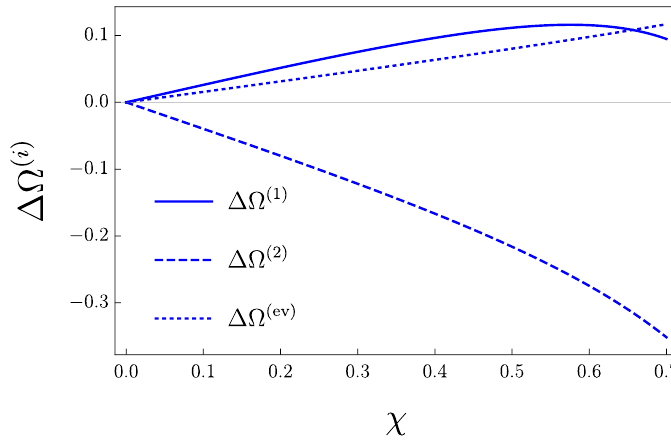
Figure 1 . Correction to the angular velocity of the black hole associated to every